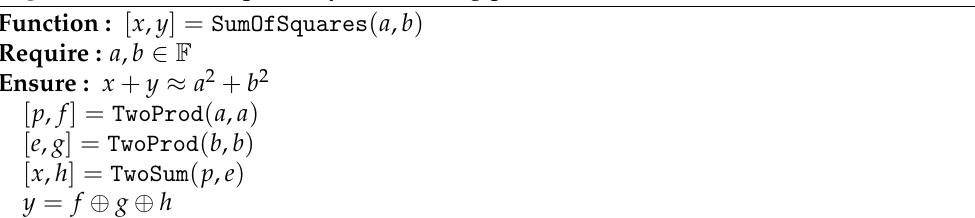
Algorithm 3 Sum of squares by two floating-point numbers